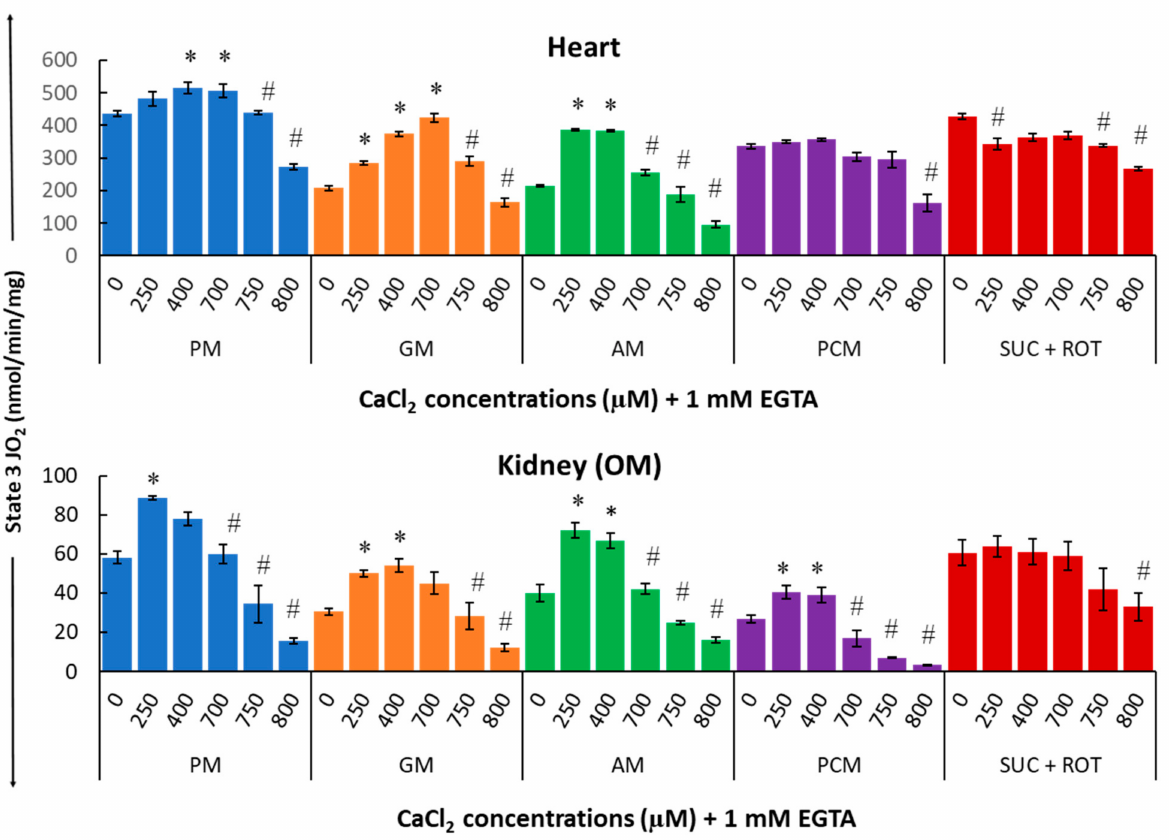
Figure 5. Summary of the different respiratory substrate-dependent effects of Ca 2+ on mitochondrial state 3 O 2 consumption rate (OCR; JO 2 ) for the heart (upper panel) and kidney OM (lower panel). The X-axis shows CaCl 2 added to the buffer in the presence of 1 mM Ca 2+ chelator EGTA. Each bar plot represents the mean value ± SEM ( n = 4–6) of state 3 OCR. The symbol ‘*’ represents significantly higher results than the baseline state 3 OCR ( p < 0.05), while the symbol ‘#’ represents significantly lower results than the peak state 3 OCR ( p < 0.05); both are based on one-way ANOVA with repeated